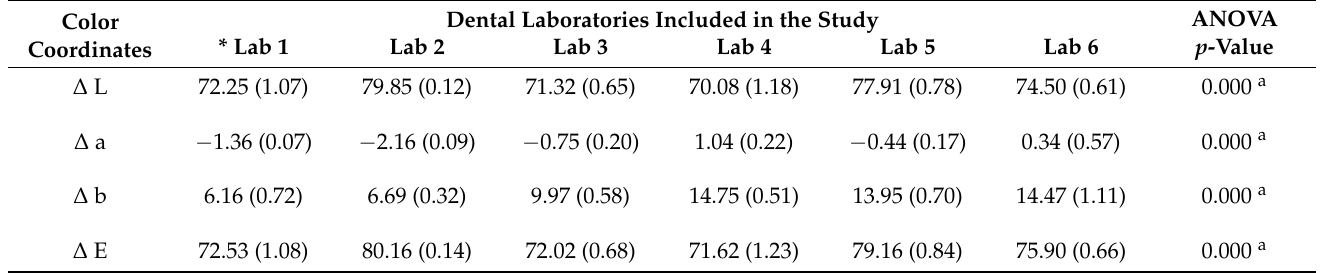
Table 3. Mean values, standard deviations, and ANOVA results of the color coordinates for shade